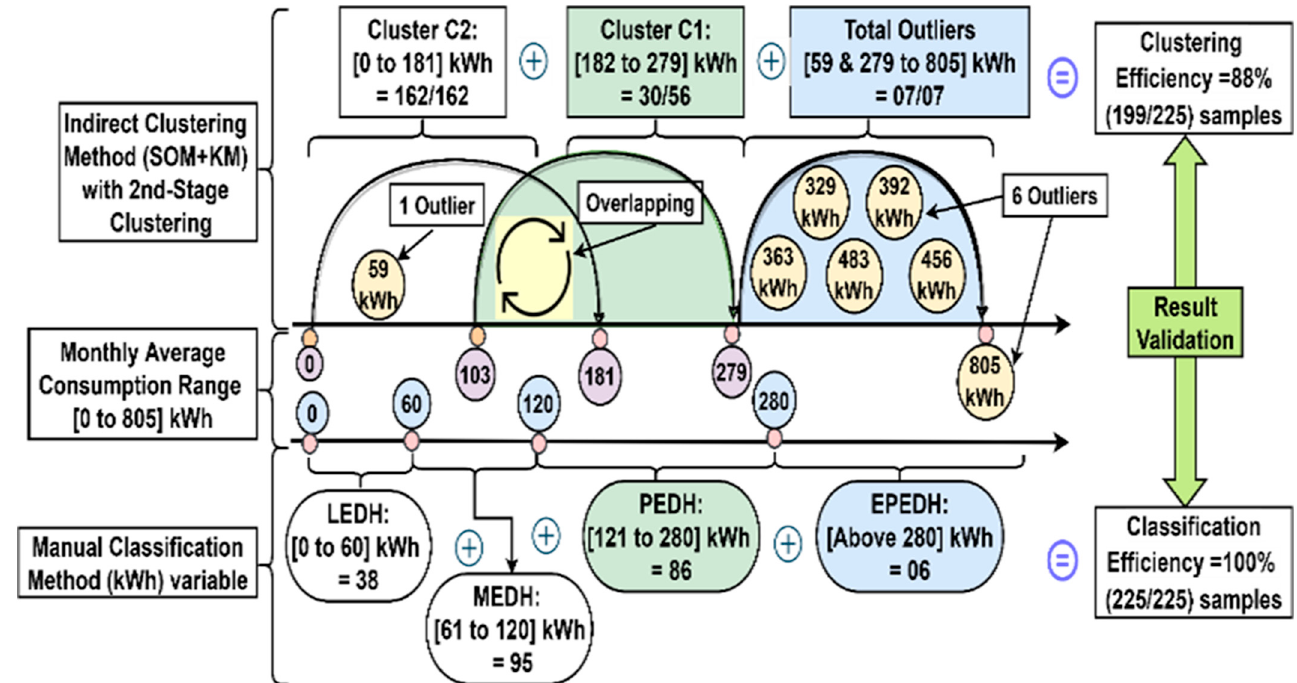
Figure 9. Proposed DM techniques’ result comparison for OHCC. Note: LEDH = less energy demand house; MEDH = moderate energy demand house; PEDH = peak energy demand house; EPEDH = extra peak energy demand house; kWh = kilowatt-hour; SOM = self-organizing map, KM = K-means; Outlier = data points away from the sample mean; Overlapping = data points belongs to more than single cluster; OHCC = optimal household consumer classification. Table 8. 1st-stage indirect KM clustering analysis of C2. Table 7. 1st-stage indirect KM clustering analysis of C1.